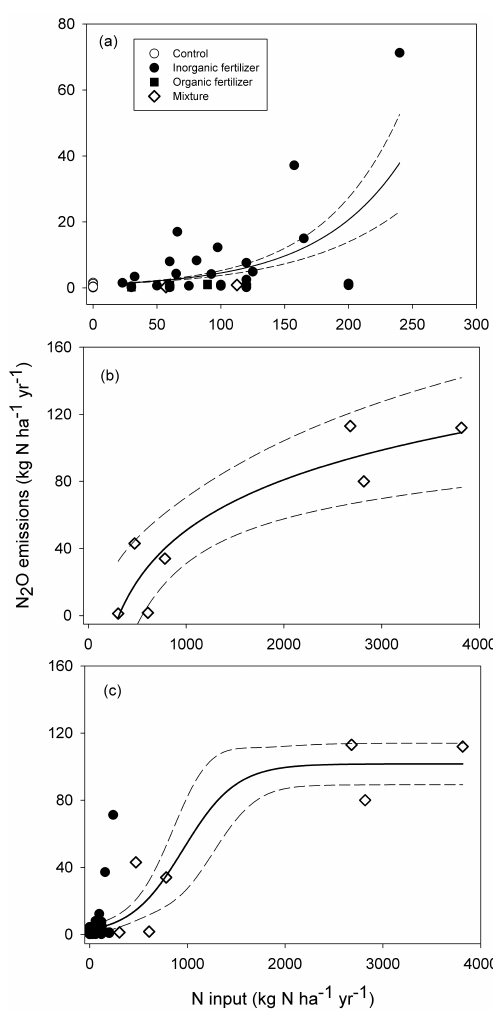
Figure 3. Relationship between nitrogen (N) input and nitrous ox- ide (N 2 O) emissions observed in Africa. N input ranged from 0 to 300 (a) , 300 to 4000 (b) , and 0 to 4000kgNha − 1 yr − 1 (c) . The dashed lines indicate 95% confidence intervals. “Control” indicates no fertilizer application, Organic fertilizer is manure; “Inorganic fertilizer” includes NPK, ammonium nitrate, and urea fertilizers; and “Mixture” indicates mixed application of organic and inorganic